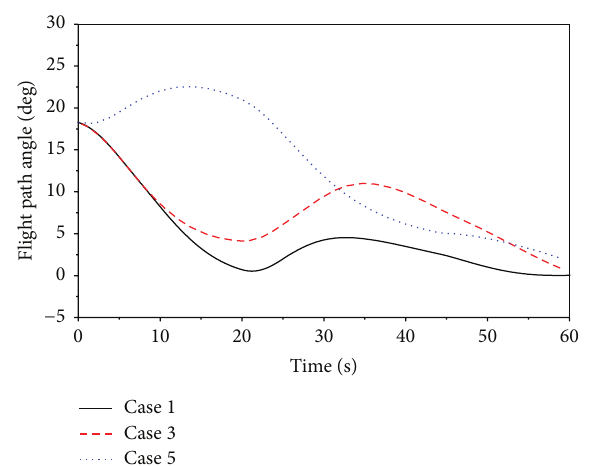
Figure 11: Angle of attack versus time.